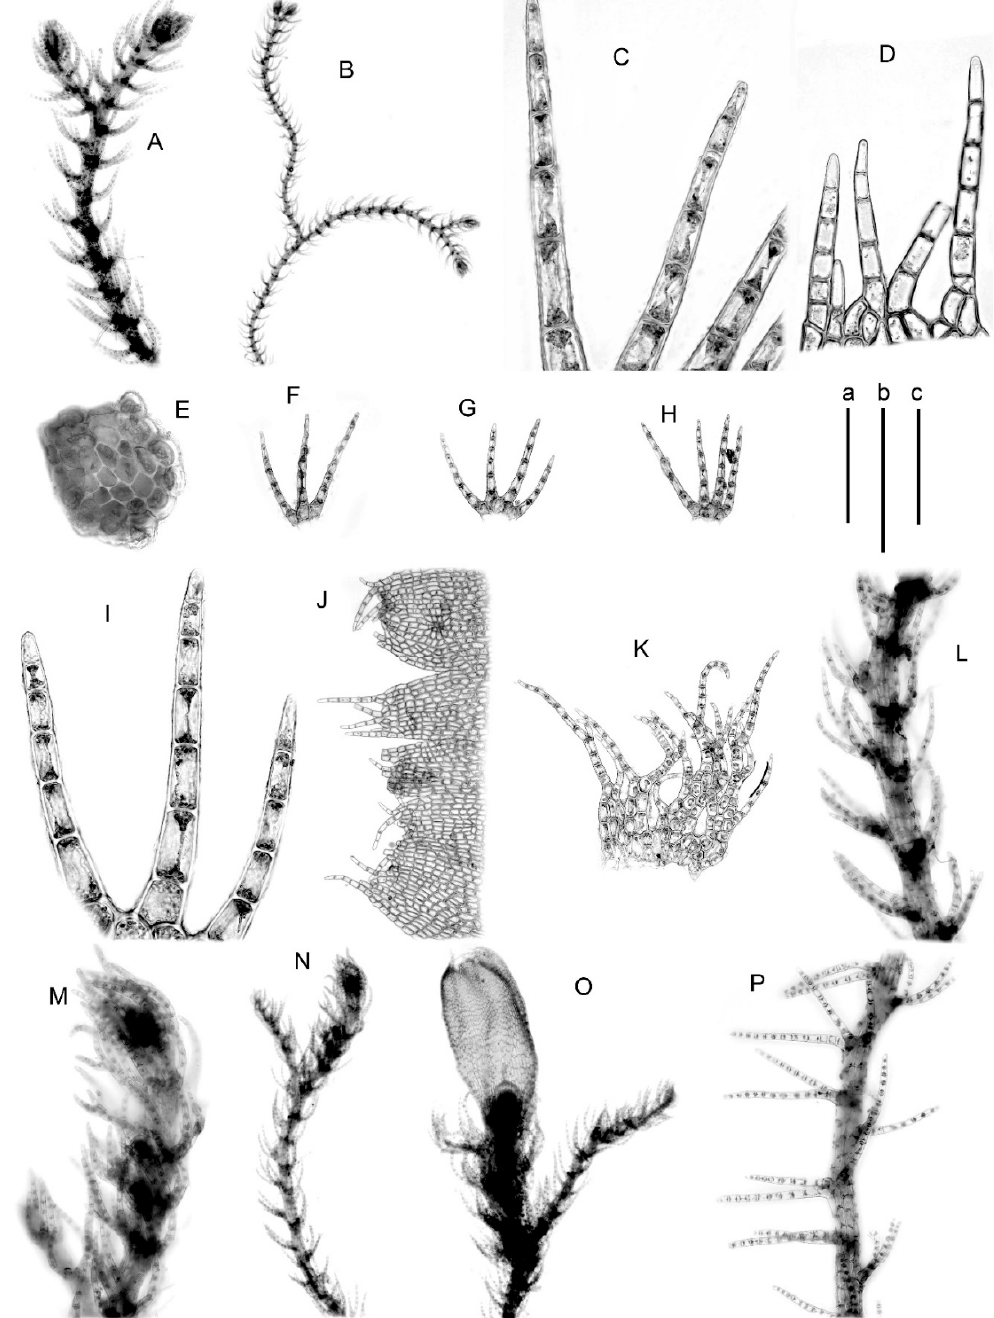
Figure 5. ( A) ,( B ) Blepharostoma minor , from J-91-51-15 (VBGI); ( C) –( O ) B. trichophyllum , from K-43-16- 15 (VBGI); ( P ) B. trichophyllum x hybrid1 , from Mag-57-2-11 (VBGI). ( A) ,( B) ,( L) –( P ) plant habit; ( C) ,( I) — (VBGI); ( P ) B. trichophyllum x hybrid1 , from Mag-57-2-11 (VBGI). ( A , B , L – P ) plant habit; ( C , I )—leaf leaf segments; ( D) ,( J) —perianth mouth armature; ( E )—stem cross-section; ( F) –( H) —leaves; ( K) — segments; ( D , J )—perianth mouth armature; ( E )—stem cross-section; ( F – H )—leaves; ( K )—female bract. female bract. Scales: a—1 mm, for ( B) ,( N) ,( O) ; b—500 µm, for ( A) ,( F) –( H) ,( J) –( M) ,( P) ; c—100 µm, for Scales: a—1 mm, for ( B , N , O ); b—500 µ m, for ( A , F – H , J – M , P ); c—100 µ m, for ( C – E ( C) –( E) .